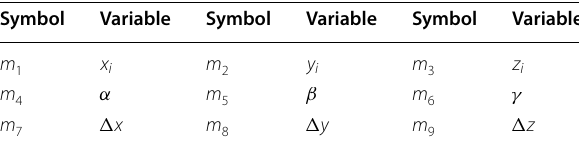
Table 1 Symbolic